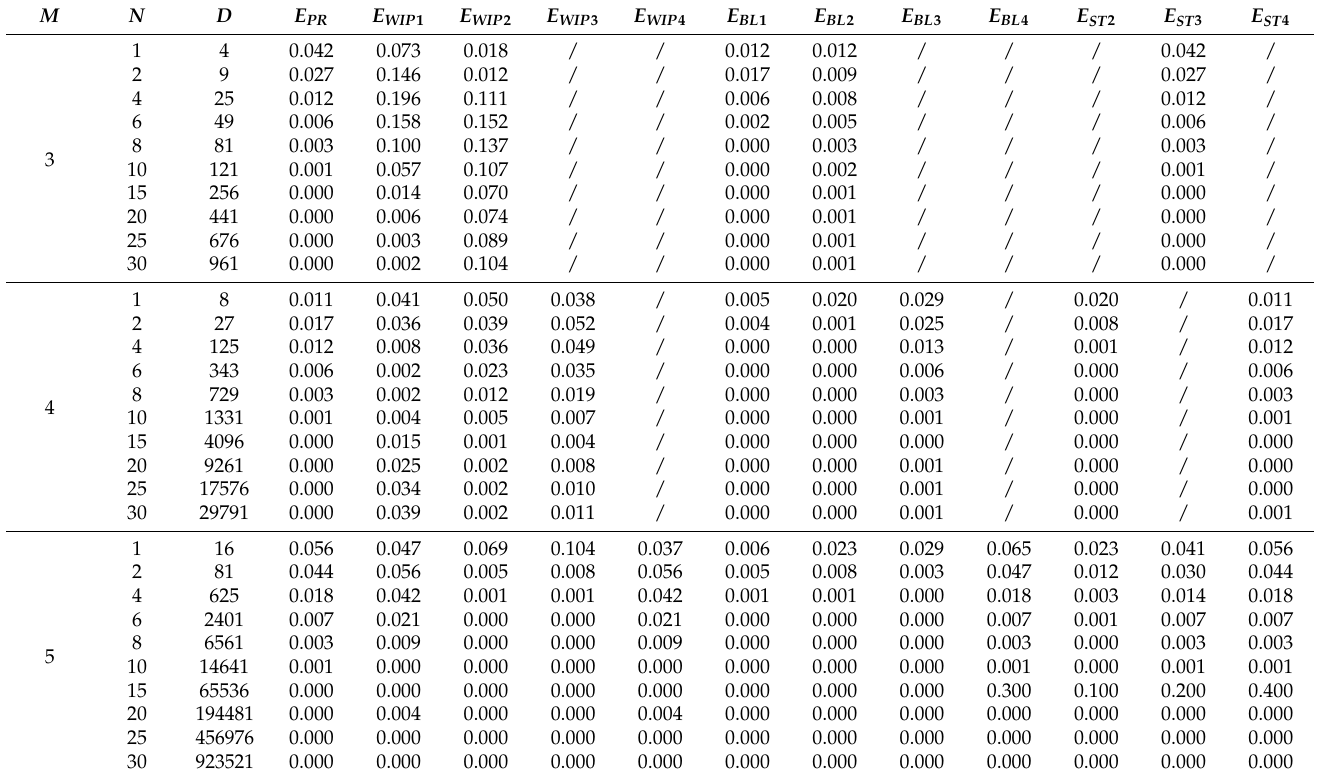
Table 2. An absolute error of the results obtained using FSM concerning the analytical